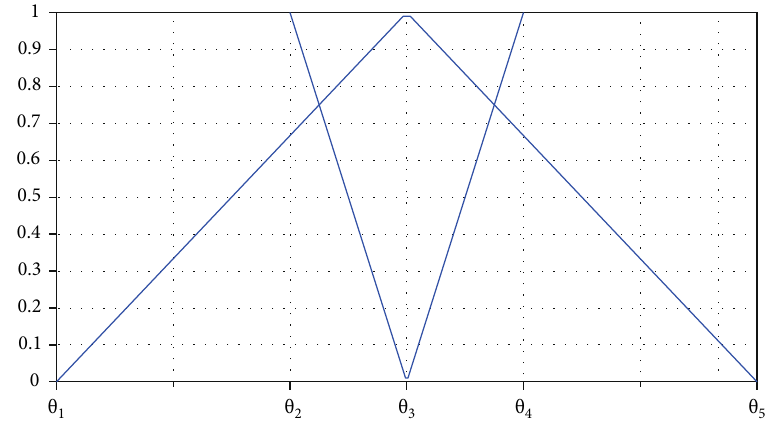
Figure 1: The fi gure of ð ϑ